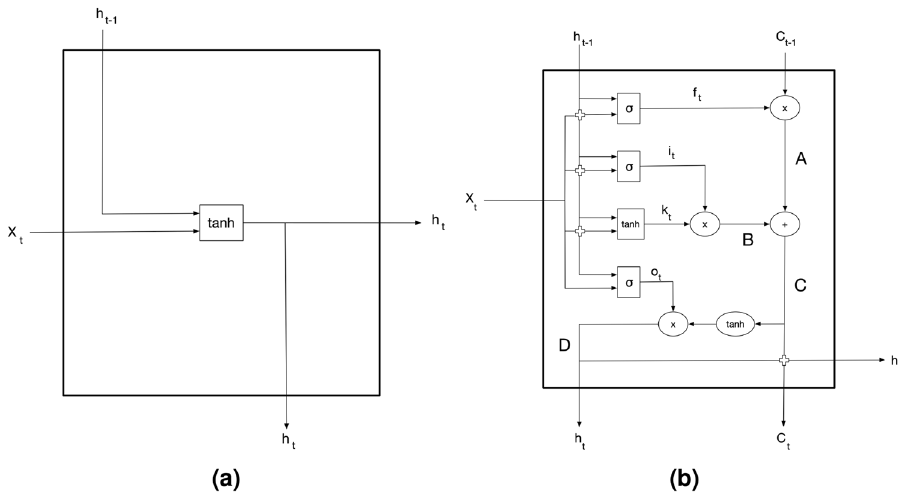
Figure 3. Simplified diagram of ( a ) a RNN cell and ( b ) a LSTM